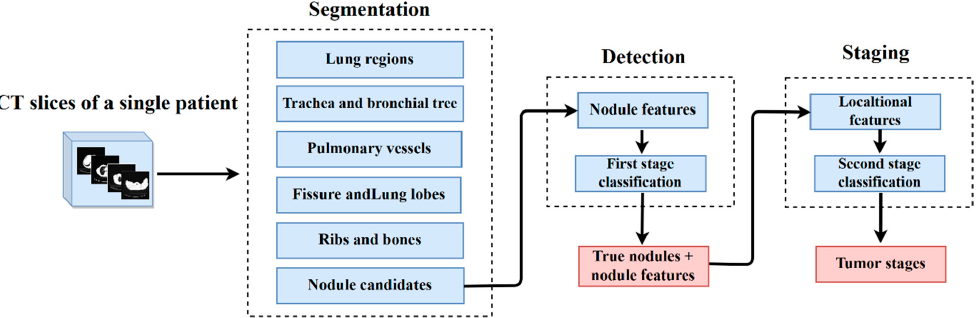
Figure 1. Typical architecture of the proposed computer-aided diagnosis system (CAD).